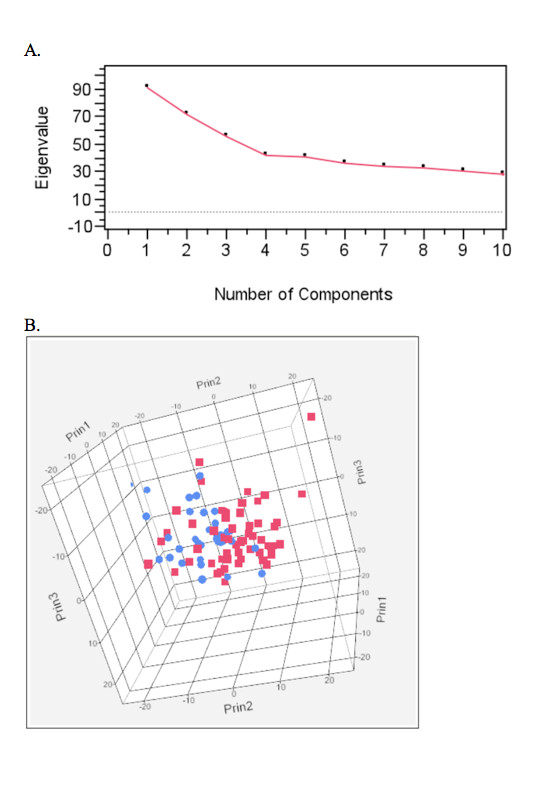
Principal Component Analysis (PCA) to assess global variation in aberration frequency between BMD and FCR. A) Scree plots of the eigenvalues first 10 components. B) Three dimensional plot of the first three components. BMD patients are indicated in red and FCR patients are indicated in blue.